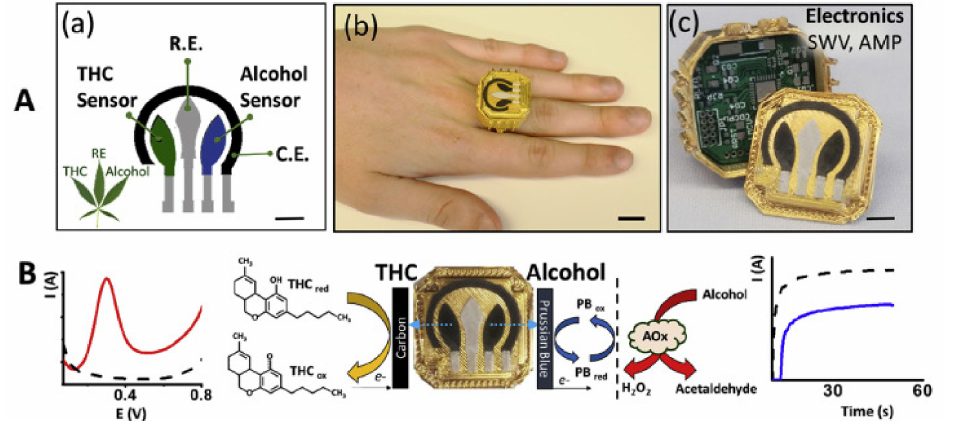
Figure 2. ( A ) (a) Sensor Design, (b) Real image of the sensor, (c) Ring polymeric case with integrated electronics and replicable electrodes; ( B ) voltammograms of THC detection and THC oxidation mechanism (red), amperogram of alcohol detection (blue) and ethanol oxidation